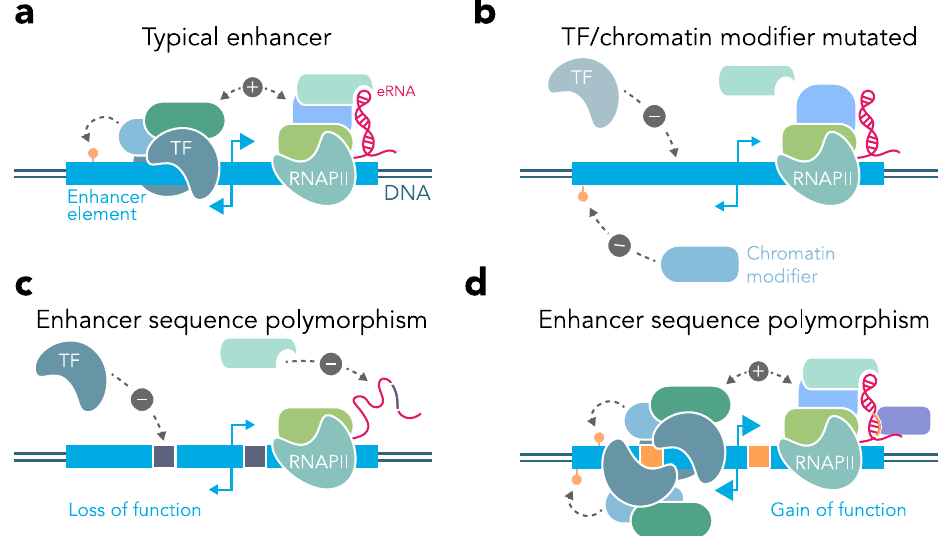
Figure 3. Enhancer dysfunction in genetic brain diseases and disorders. a , Illustration of enhancer-mediated interactions including transcription factor (TF) binding to motifs in enhancer DNA sequence, recruitment of chromatin modifying enzymes and RNA polymerase (RNAPII), as well as transcription of eRNAs. These interactions increase binding of transcription factors and epigenetic modifiers at gene promoters to regulate linked genes in cis. b , Mutations in chromatin modifiers and TFs commonly found at enhancers often lead to neurodevelopmental and intellectual disability. This could occur via loss of DNA binding, loss of catalytic activity, or loss of protein-ribonucleotide or protein-protein interactions that mediate enhancer function. c-d , Sequence polymorphisms located in enhancers could confer either loss of function (e.g., if polymorphism includes TF motif or results in change to eRNA sequence that abolishes protein-ribonucleotide interactions), or potentially gain of function (e.g., via recruitment of new TFs or novel eRNA-protein